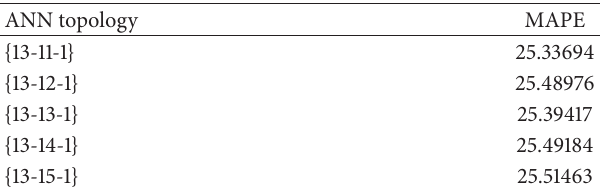
Table 4: The topology setting results for the ANN model alone. ANN topology